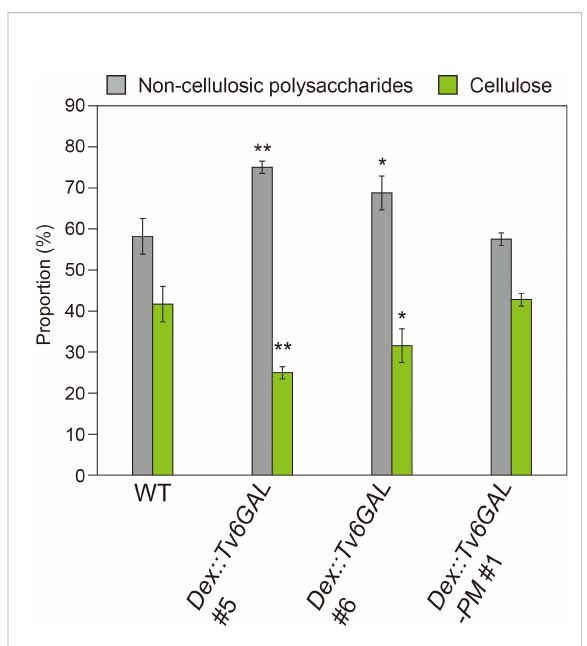
FIGURE 7 Proportion of cell wall fractions. Plants were grown on MS-agar media containing 10 µM Dex under continuous light for 10 days. Using the Updegraff method, the proportion of non-cellulosic polysaccharides and cellulose was determined. Data are mean values with ± SD (n = 3 biological replicates). Asterisks indicate signi fi cant differences from WT plants (Stud ’ s t -test, *, P <0.05; **, P